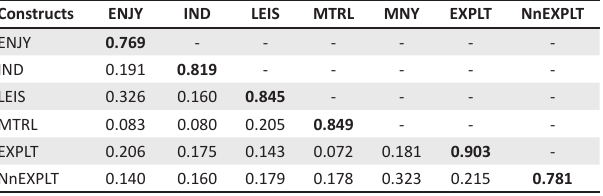
TABLE 3: Correlation matrix to assess the discriminant validity.